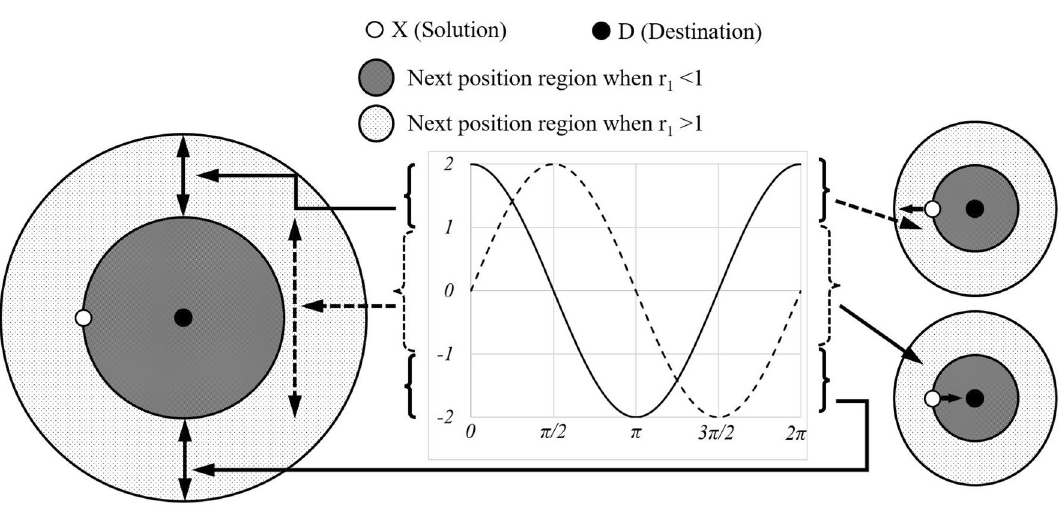
Figure 3. Sine and cosine with the range in [− 2, 2] allow a solution to go around (inside the space between them) or beyond (outside the space between them) the